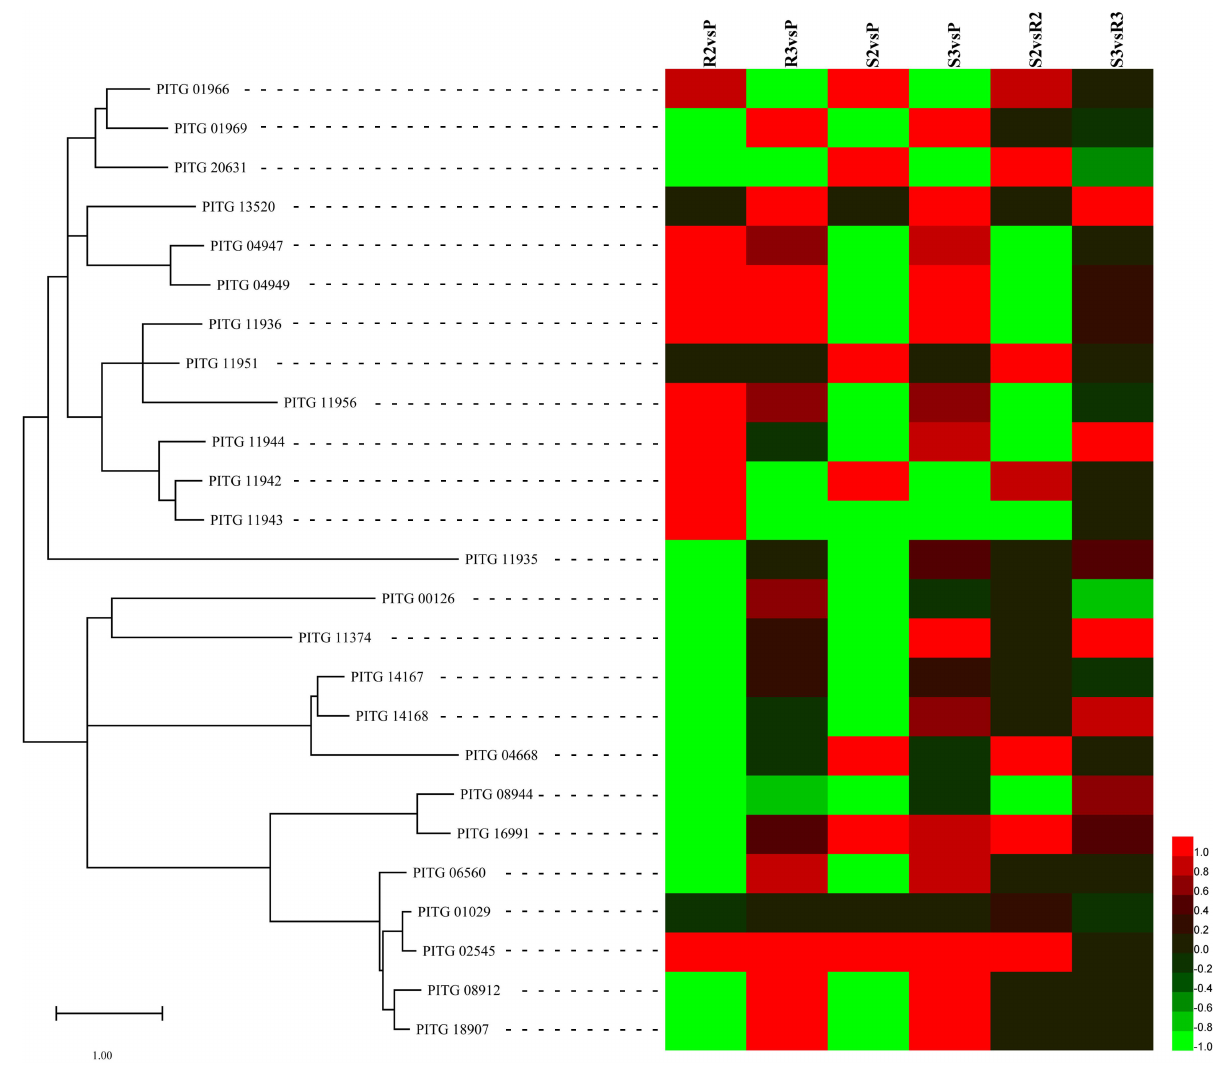
FIGURE 5 | Expression patterns of the differentially expressed cell wall-degrading enzyme (CWDE)-encoding genes. Sequences of CWDEs, including AA17, cellulase, pectin lyases, and pectate lyases, were submitted to MEGA 11 to draw a neighbor-joining tree (Tamura et al., 2021). The log 2 FC values of the CWDE genes were calculated based on the expression levels and used to draw heatmaps by HemI (version 1.0) (Deng et al.,